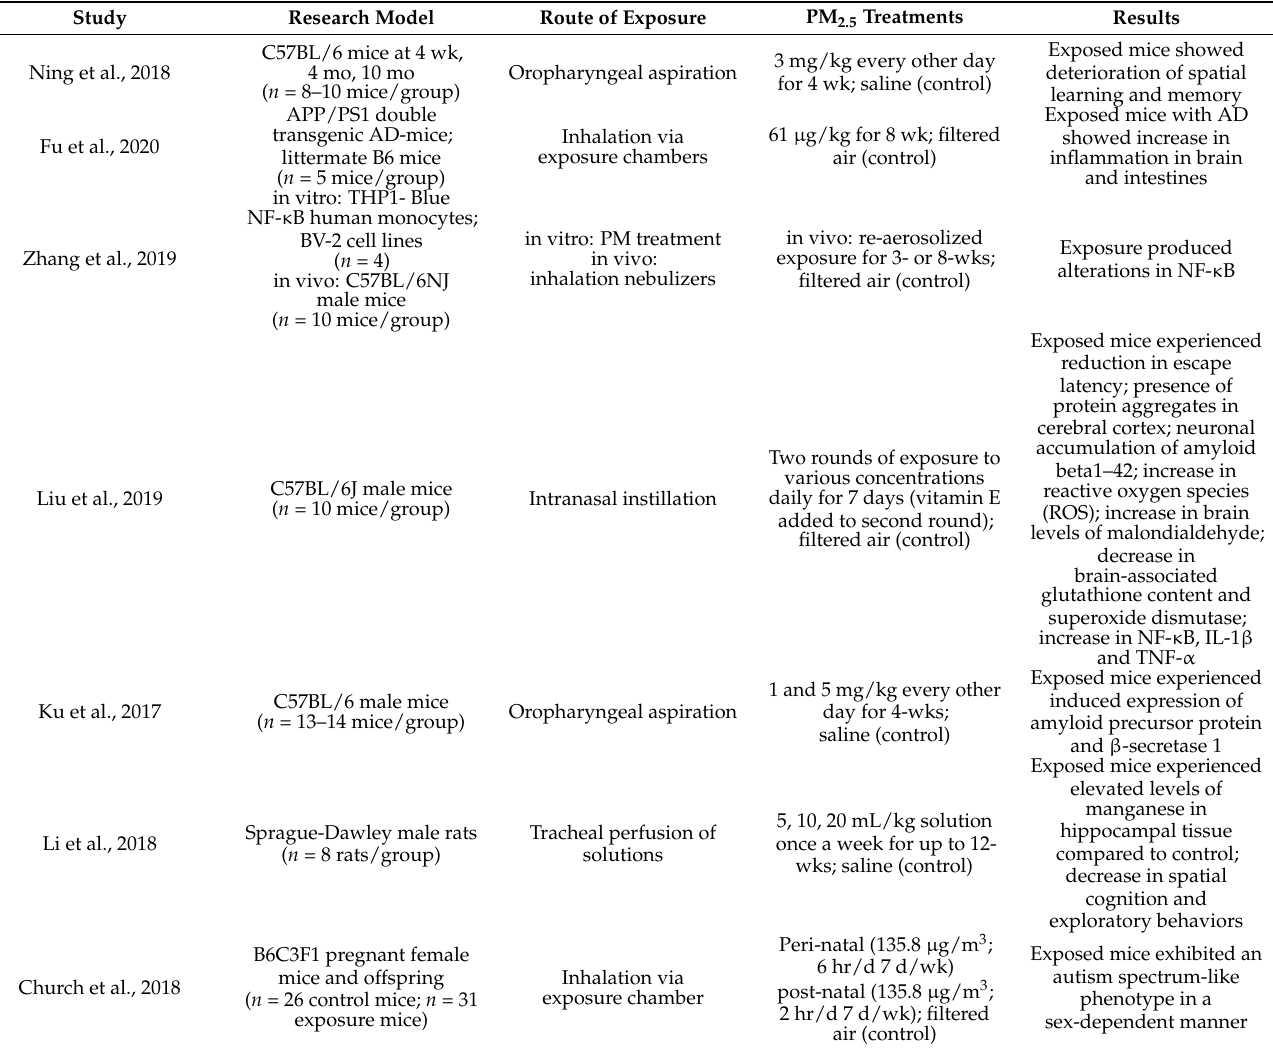
Table 2. Summary of toxicological studies on particulate matter (PM 2.5 ) and associated metals and their effects on brain